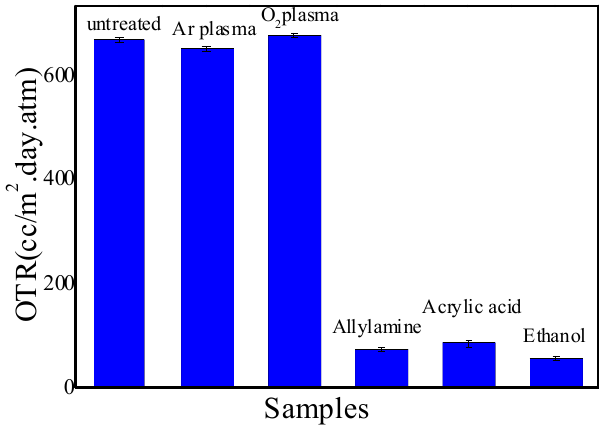
Figure 1. The dependence of OTRs of SiOx coating PE on the monomers.